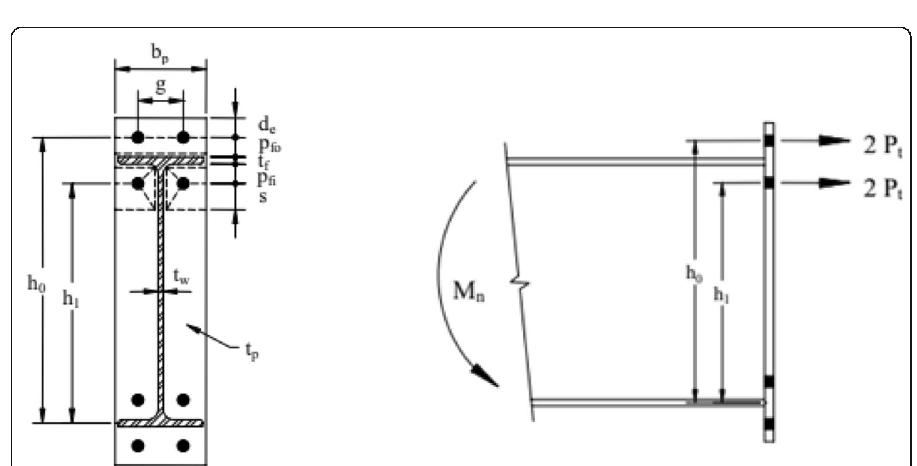
Fig. 16 Geometry, yield line, and bolt force model